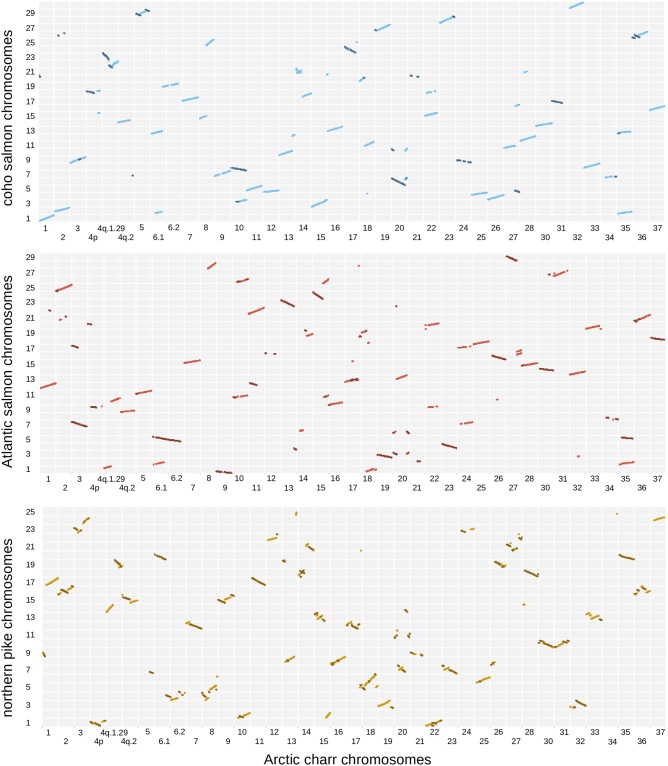
Comparison of genome assemblies from selected species to the Arctic charr genome assembly.The lighter colors represent alignments that are in forward orientation, while the darker colors represent reverse orientations. For the Arctic charr chromosomes, all numbers indicate corresponding chromosome names without the prefix of AC (and 0 for those below 10). For all other species, the chromosome numbers represent NCBI designations without letter prefixes.